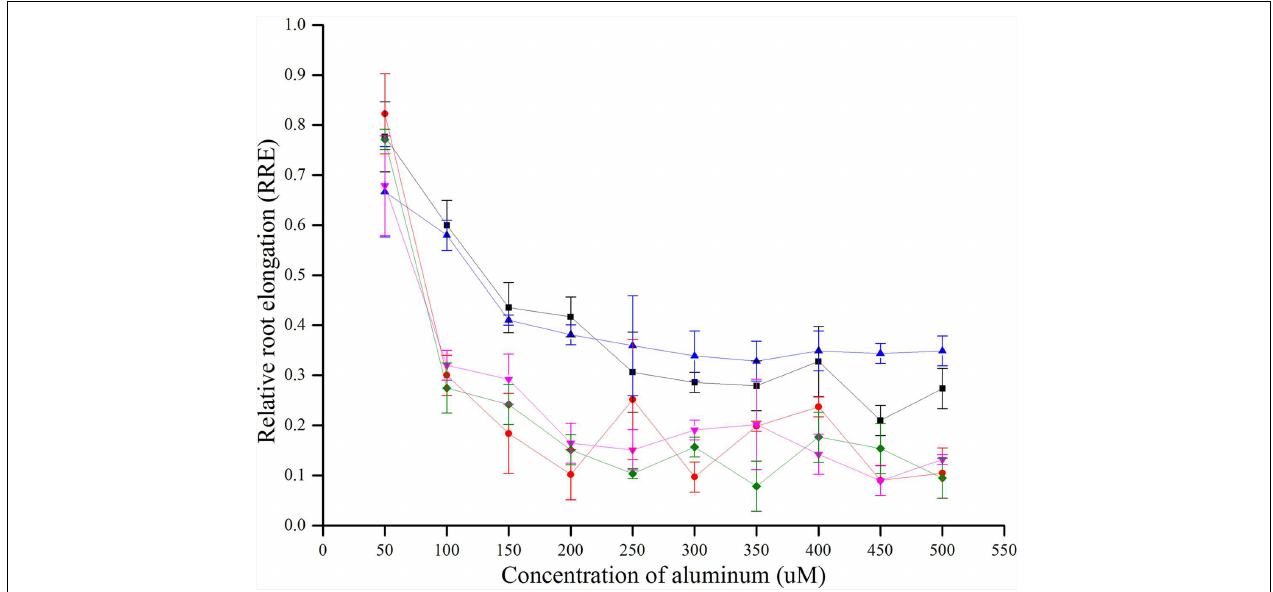
FIGURE 1 | RRE of five CKs (controls) treated with different concentrations of Al 3 + for 24 h.